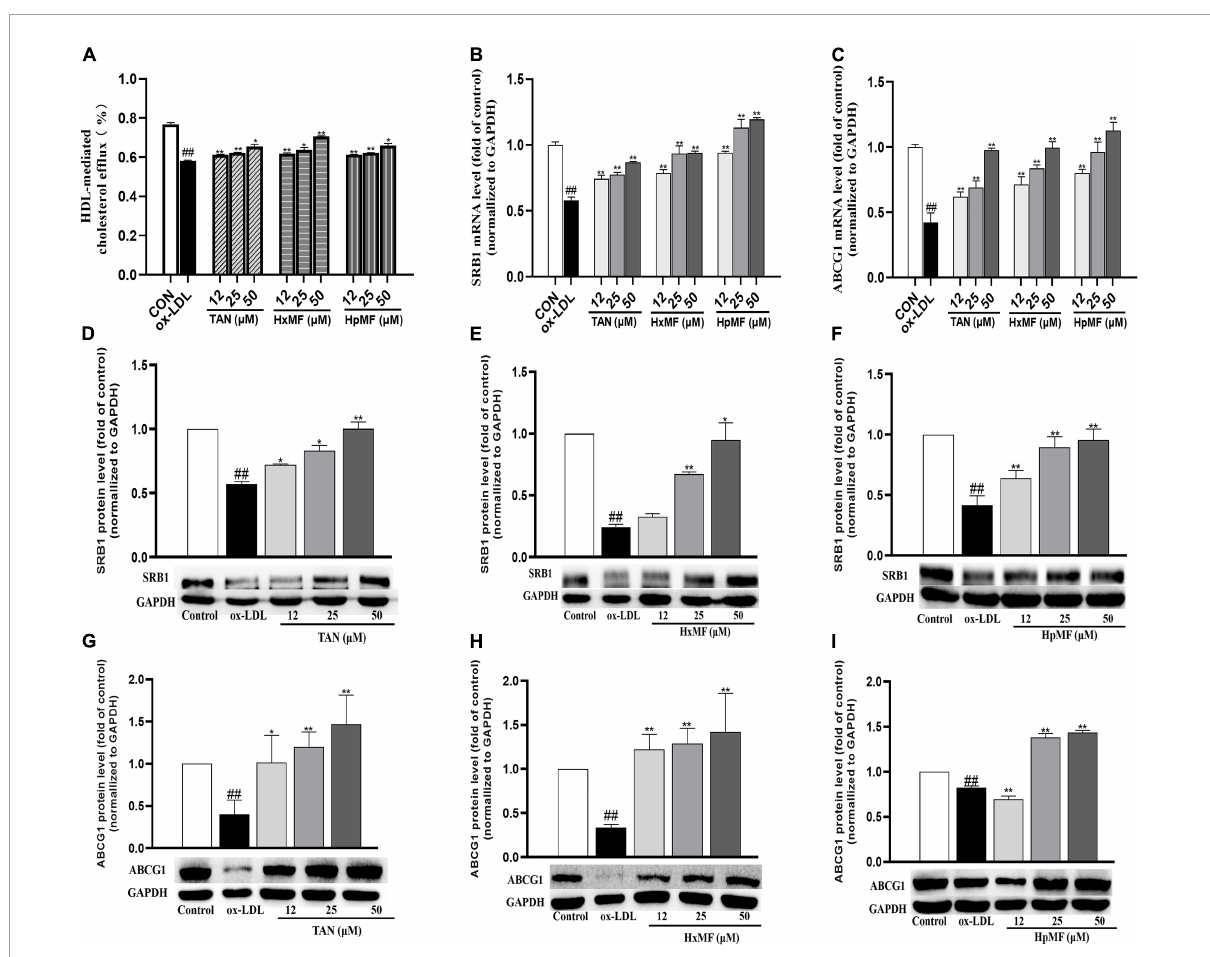
FIGURE6 Effects of TAN, HxMF, and HpMF on ox-LDL-induced cholesterol efflux (A) ; effects of TAN, HxMF, and HpMF on mRNA expression of SRB1 and ABCG1 in ox-LDL-treated RAW264.7 cells (B,C) ; effects of TAN, HxMF, and HpMF on protein expression of SRB1 in ox-LDL-treated RAW264.7 cells (D–F) ; and effects of TAN, HxMF, and HpMF on protein expression of ABCG1 in ox-LDL-treated RAW264.7 cells (G–I) . All experiments were run in triplicate and data showed mean ± SD. ## p < 0.01 compared with the control group, * p < 0.05 and ** p < 0.01 compared with the ox-LDL